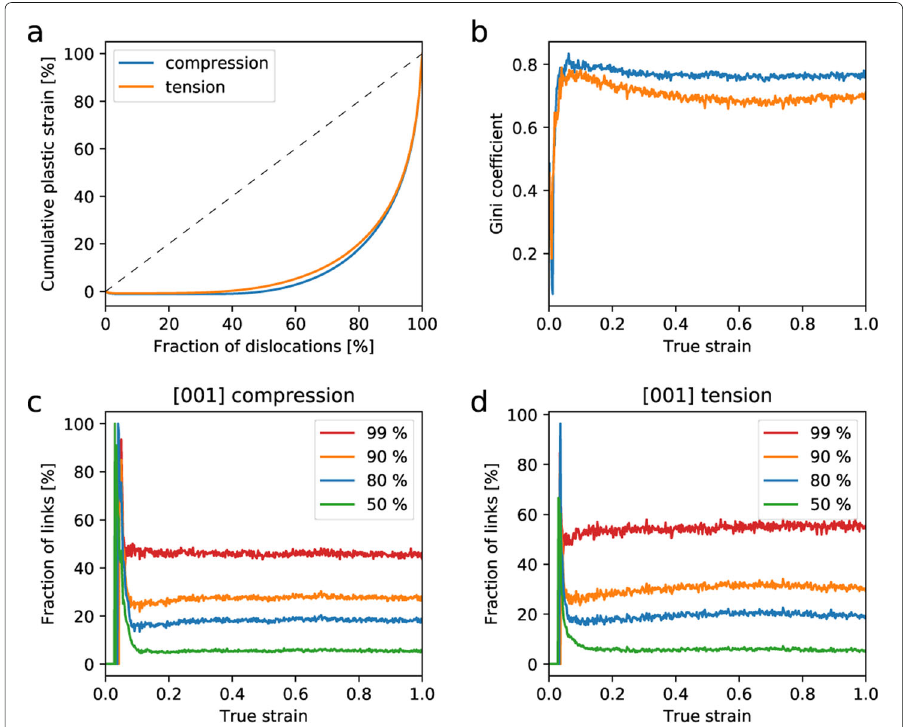
Fig. 8 Inequality of participation of dislocation links in producing plastic strain. a Cumulative plastic strain as a function of the fraction of dislocation links ordered from the lowest to the highest contributor. The dashed line corresponds to equal participation. b Evolution of the Gini coefficient under compression and tension. c – d Evolution of percentile contributions to plastic strain under compression ( c ) and tension ( d ): each line shows the fraction of highest contributor links responsible for a certain percentile of plastic strain, plotted as functions of